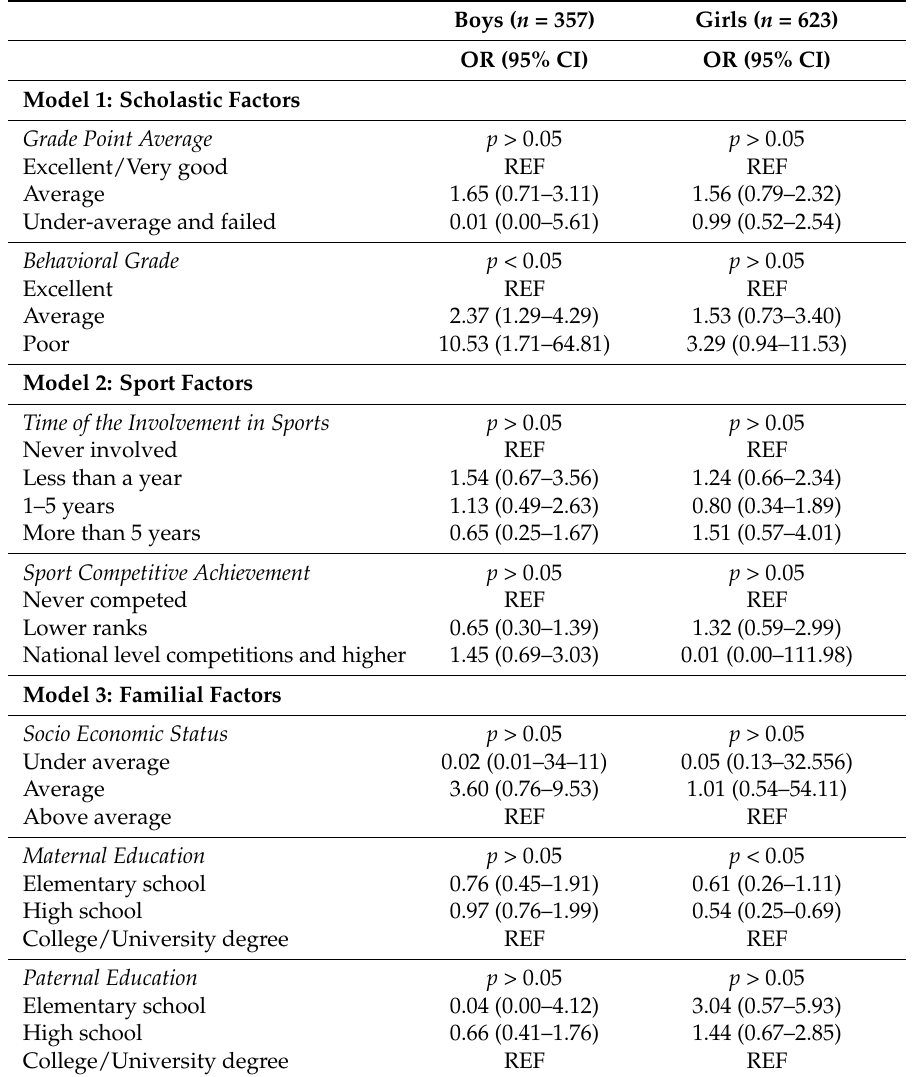
Table 3. Logistic regression models for consumption of illegal drugs in boys and